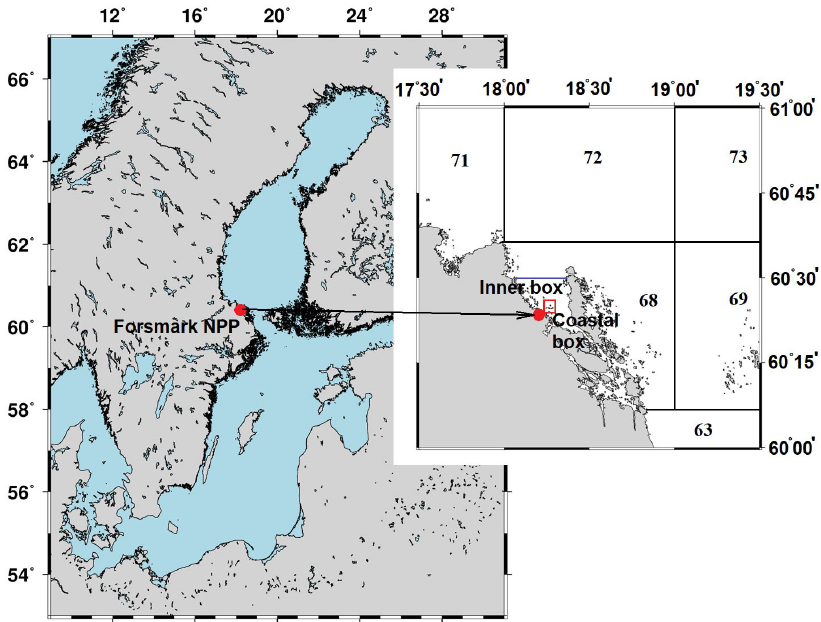
Figure 6. Box system around the Forsmark NPP. The numbers denote regional boxes in the box system of the Baltic Sea (Bezhenar et al., 2016). An additional “Inner box” is separated from regional box 68 by the blue line. The coastal box (red rectangle) surrounds the area where cooling water from NPP is discharged.